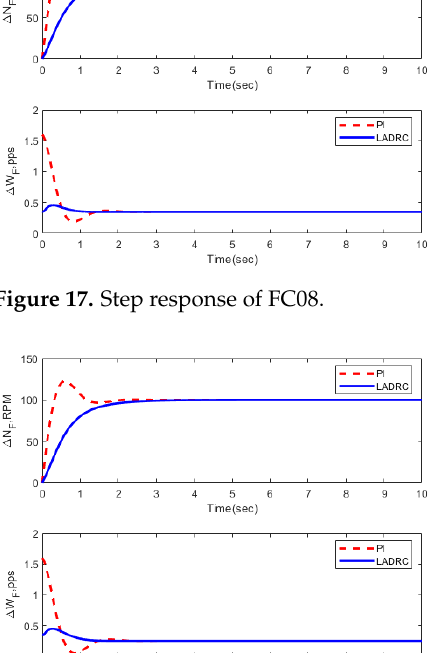
Figure 18. Step response of FC09.